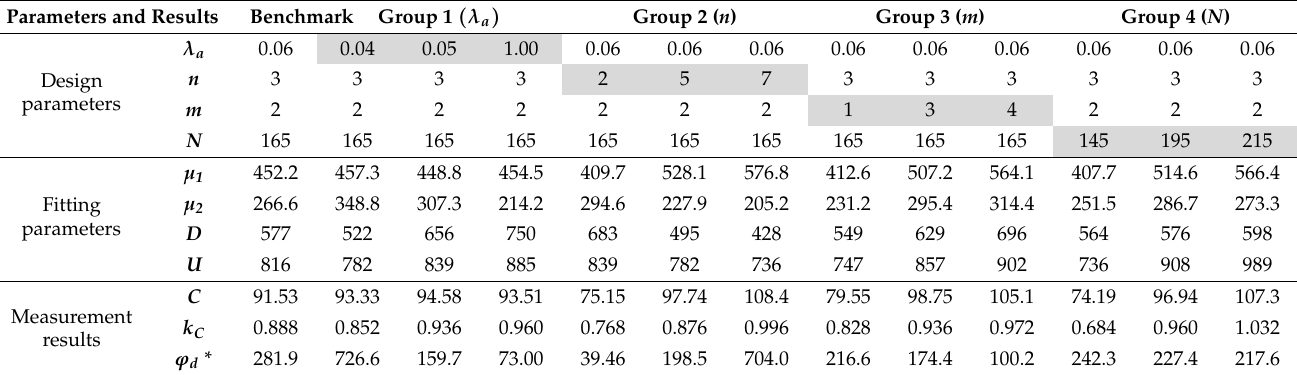
Table 4. Design parameters and corresponding results to different